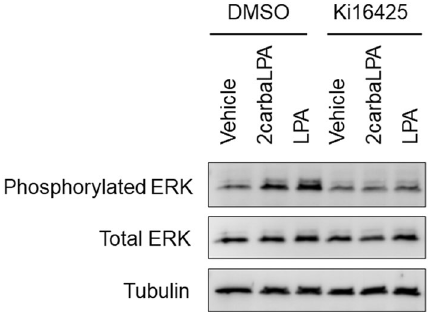
Figure 3. Effects of 2-carba-lysophosphatidic acid (2carbaLPA) on the phosphorylation of the extracellular signal-regulated kinase (ERK) protein. HeLa cells were preincubated with 10 µM Ki16425 for 30 min at 37 °C and then incubated with 10 µM 2carbaLPA, lysophosphatidic acid (LPA) 18:1, or vehicle for 5 min at 37 °C. Protein levels of phosphorylated ERK, total ERK, and α-tubulin were determined by western blot analysis. The full-length blots are shown in the Supplementary Fig. S2.